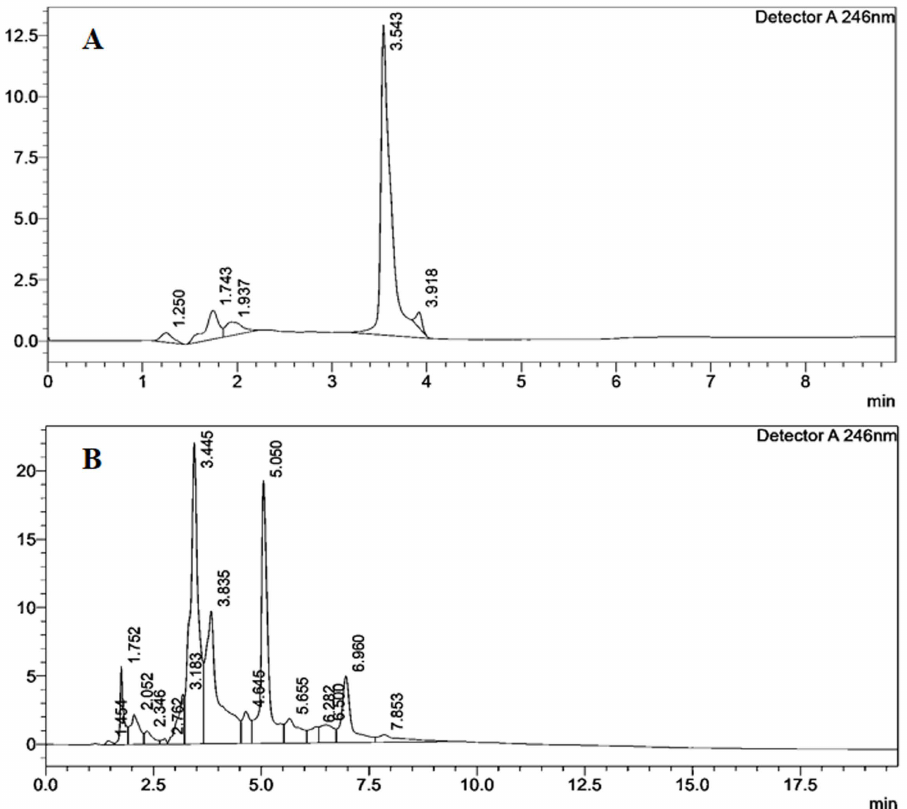
Figure 4. High-performance liquid chromatography (HPLC) chromatogram of palmitic acid (A) and spittlebug biofoam P. costalis ( B ) at 246 Figure 2. Gas chromatography–mass spectrum of P. costalis foam.